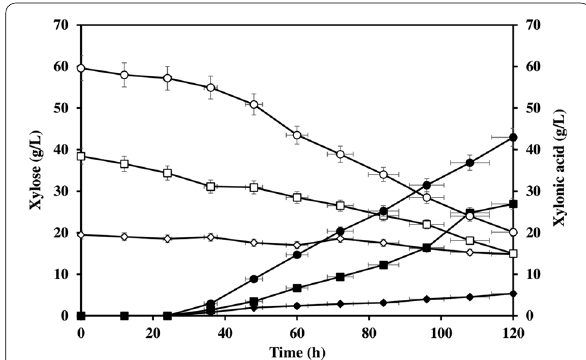
Fig. 4 Xylose utilization (open symbols) and xylonic acid production (closed symbols) by C. glutamicum ATCC 31831 (pVWEx1- xylB ) in rice straw hydrolysate containing different concentrations of xylose 20 g/L (open diamond), 40 g/L (open square) and 60 g/L (open